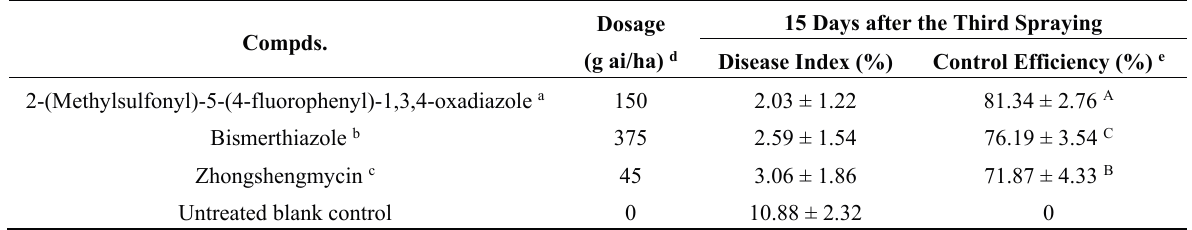
Table 3. Field trials of the testing compounds against rice bacterial leaf blight. Compds.